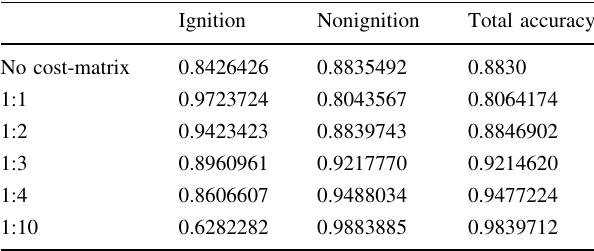
Table 7 Prediction precision of different sample ratios using the RF- cost sensitive